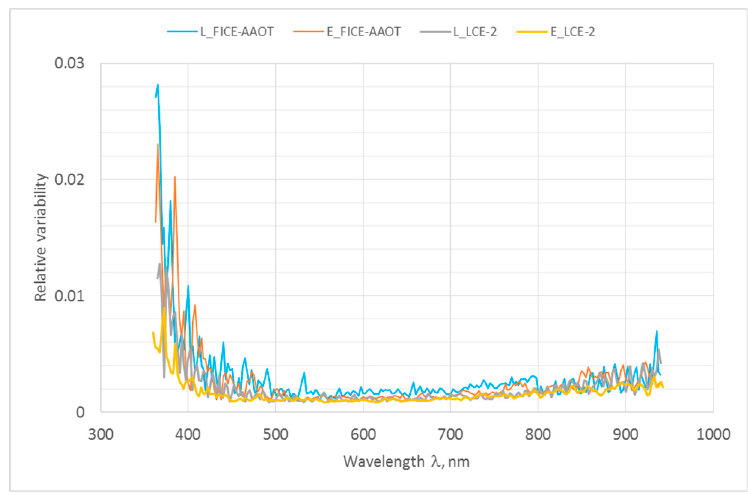
Figure 9. Relative variability of calibration coefficients of radiance ( L ) and irradiance ( E ) sensors with